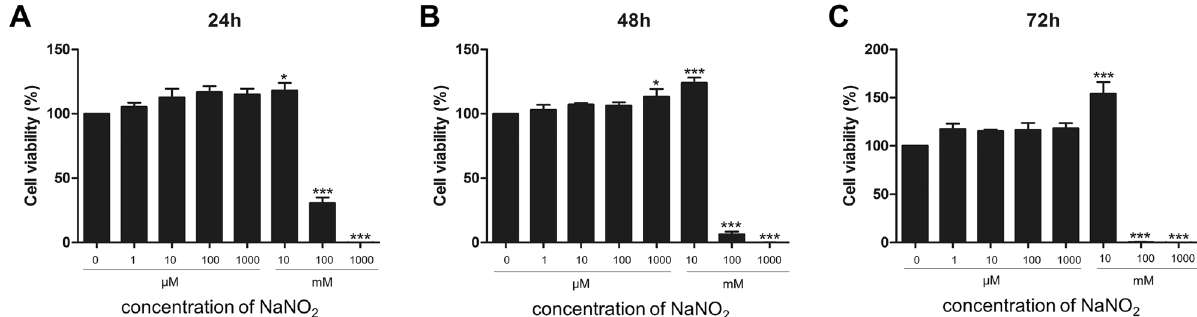
Figure 1. Keratocytes’ viability was measured after different concentrations (1 μM to 1000 mM) of sodium nitrite exposure for 24 ( A ), 48 ( B ) and 72 h ( C ). Sodium nitrite did not harm cultured keratocyte viability up to 10 mM concentration for 72 h. However, high concentrations (100 mM or 1000 mM) of sodium nitrite decreased keratocyte viability. *p < 0.05, ***p <